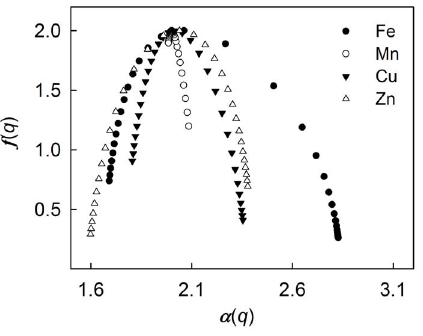
Figure 3. Single multifractal spectrum for selected soil trace elements at 2 15 to 15 range of q evaluated at 1 increment.